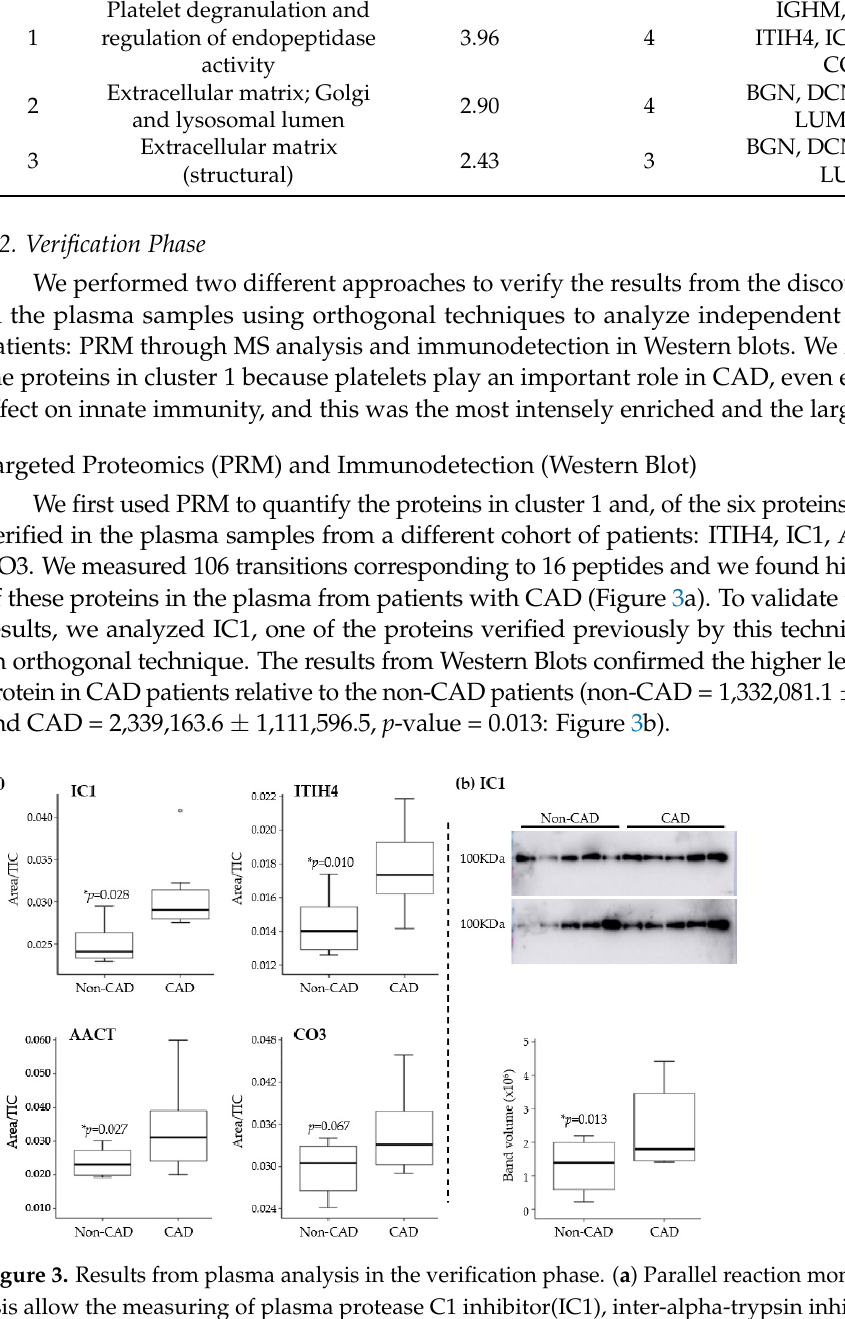
Table 3. Functional analysis of the differentially expressed proteins. The proteins are represented in clusters according to their function. The enrichment score (enrich. score), number of terms (N. of terms) and proteins included in each cluster are shown. IGHM, Ig mu chain C region;PON1, serum paraoxonase/arylesterase 1; ITIH4, inter-alpha-trypsin inhibitor heavy chain H4; IC1, plasma protease C1 inhibitor; AACT, alpha-1-antichymotrypsin; CO3, complement C3; BGN, biglycan; DCN, decorin; COFA1, collagen alpha-1(XV) chain; LUM, lumican; FA9, coagulation factor IX. Cluster Function Enrich. Score N. of Terms Proteins Platelet degranulation and IGHM, PON1, 1 regulation of endopeptidase 3.96 ITIH4, IC1, AACT, activity Extracellular matrix; Golgi and lysosomal lumen